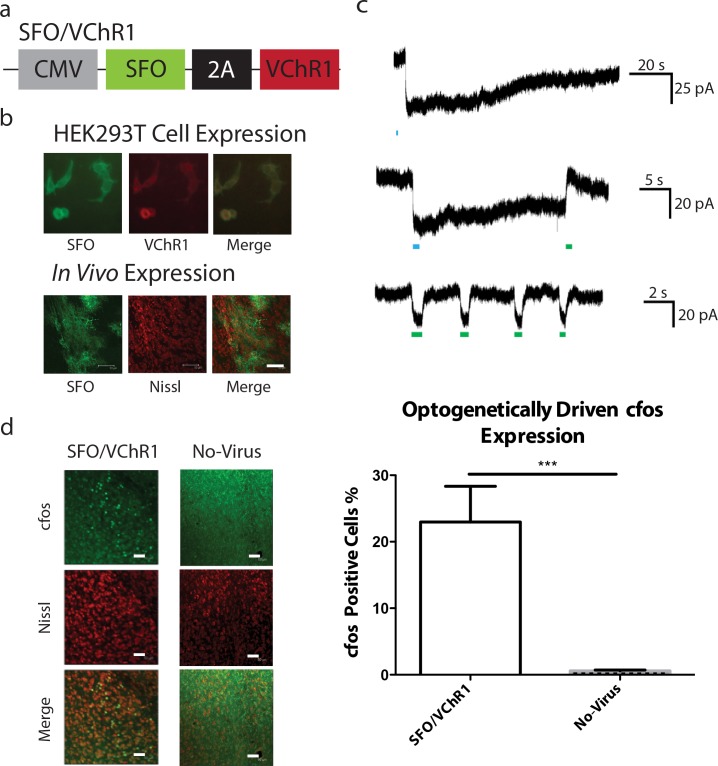
Viral design, expression, and electrophysiological and molecular characterization of SFO/VChR1.(a) SFO/VChR1 viral design. (b) Expression of SFO/VChR1 in HEK293T cells and in vivo. HEK293T cells were infected with SFO/VChR1; VChR1 and SFO were visualized by mCherry and EYFP fluorescence respectively. Cells in vivo were stained for EYFP and were counterstained with Nissl. Scale bar, 50um. (c) Whole-cell recordings from SFO/VChR1 expressing HEK293T. A 473nm light pulse, designed to activate SFO, triggered a stable depolarizing step in membrane potential that was maintained following the offset of the pulse and reversed by a 532nm green light pulse. Additionally, inward depolarizing currents were generated that lasted for the duration of a 532nm green light pulses designed to turn on VChR1. (d) The LA of one cohort of SFO/VChR1 (n = 4) expressing animals was illuminated with 532nm green light while another cohort of control animals also received 532nm light illumination but did not express an opsin (No-Virus, n = 6). The animals were sacrificed and the brains were stained for cfos. The SFO/VChR1 cohort had a significantly larger population of cfos positive neurons than the No-Virus cohort (unpaired, two-sided t-test, t(8) = 5.25, p < 0.001). The percent of cfos positive cells represent the fraction of cfos positive neurons over the total number of neurons as counted by nissl staining: SFO/VChR1-Light; 22.96 ± 5.38%, No Virus; 0.58 ± 0.14%. Error bars are mean ± SEM, *** = p < 0.001.